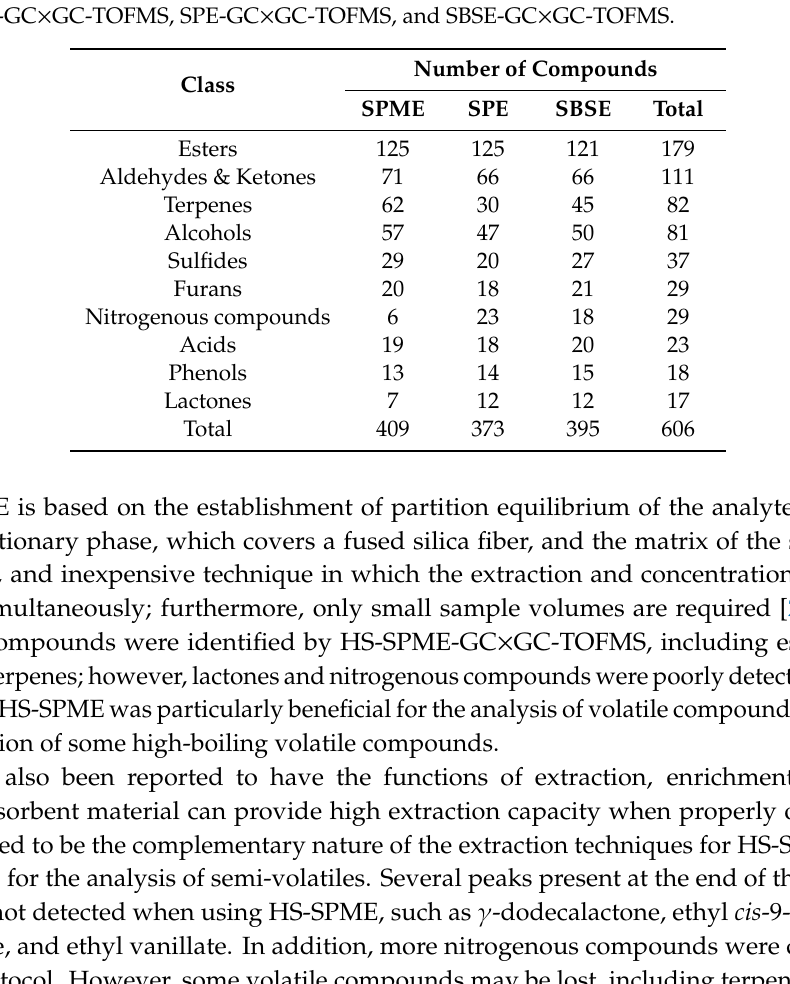
Figure 4. Comparison of identification compounds obtained by HS-SPME-GC×GC-TOFMS, SPE-GC×GC-TOFMS, and SBSE-GC×GC-TOFMS. ( A ) (Venn diagram) and ( B ) (Bar plot graph displaying compound distribution according to chemical class). Table 1. Comparison of volatile compounds detected in Chinese herbaceous aroma-type Baijiu